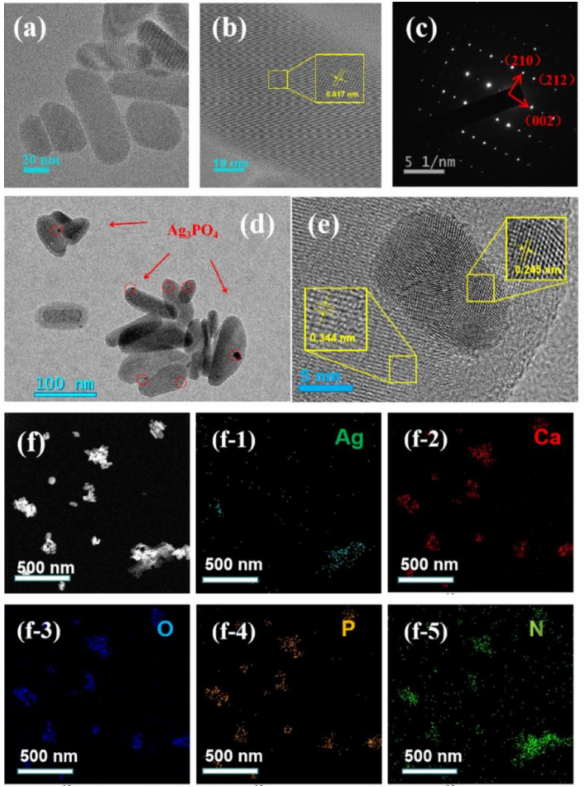
Figure 3. ( a , b ) HRTEM images of CNH(III), ( c ) rutile spots of CNH(III), HRTEM images ( d , e ), elemental mapping images ( f ) of 3:1-Ag/CNH(III), image of Ag ( f-1 ), Ca ( f-2 ), O ( f-3 ), P ( f-4 ) and N ( f-5 )